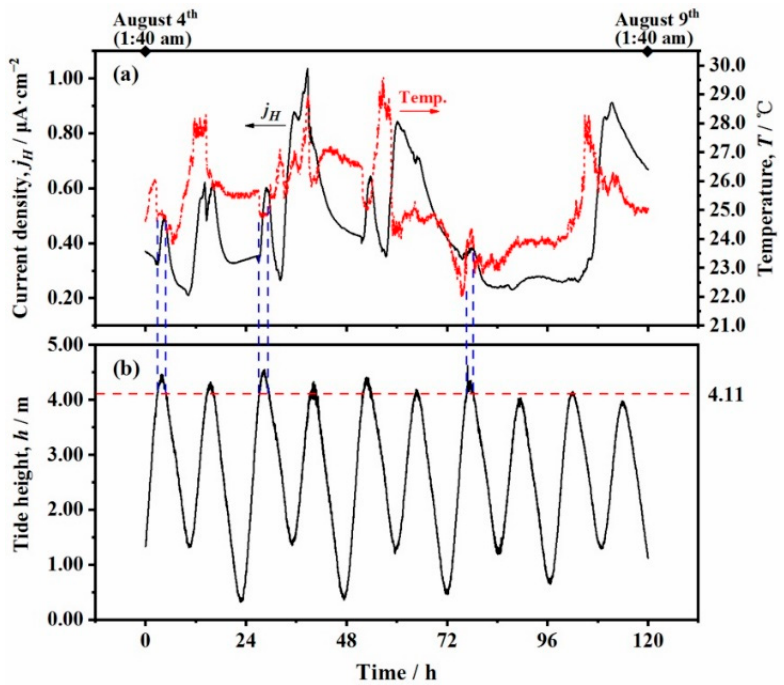
Figure 8. Time variations of the hydrogen permeation current density of the sensor exposed to the splash zone and the corresponding temperature ( a ), as well as tidal changes ( b ) from 4 August to 9 August during outdoor hydrogen permeation test. Figure 9 shows transients of the hydrogen permeation current density of the sensor exposed to the splash zone, and changes in temperature and tide. The specific position